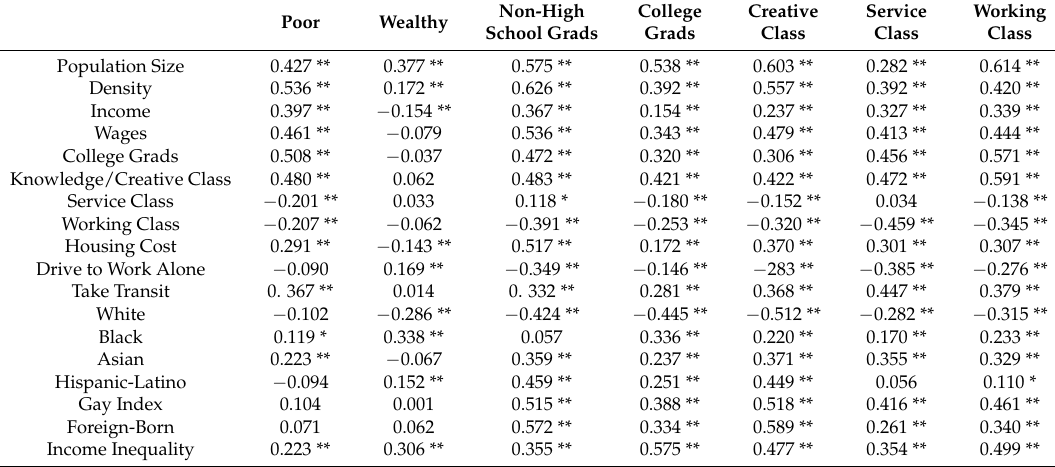
Table A1. Correlation Results for the Seven Sub-Groups of Economic Segregation. Poor